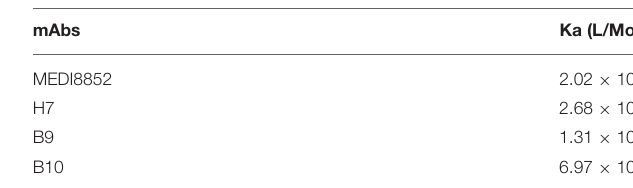
TABLE 1 | Affinity constant (Ka) measurements of mAbs by